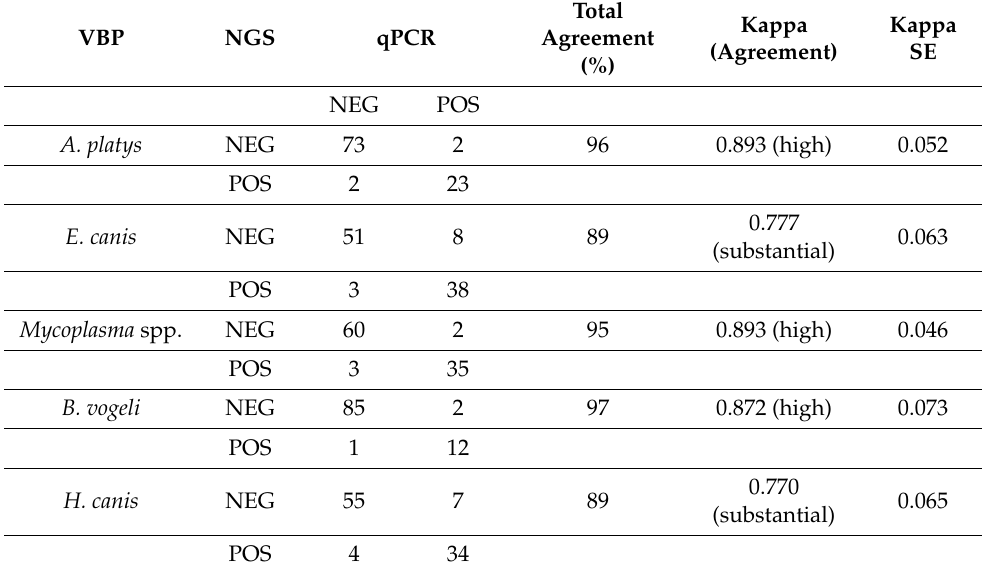
Table 3. NGS vs. multiplex qPCR agreement statistics for five VBPs. POS = positive, NEG = negative, SE = standard error. Kappa agreement level defined as poor if coefficient ( k ) is ≤ 0.20, fair agreement if 0.21 ≤ k ≤ 0.40, moderate agreement if 0.41 ≤ k ≤ 0.60, substantial agreement if 0.61 ≤ k ≤